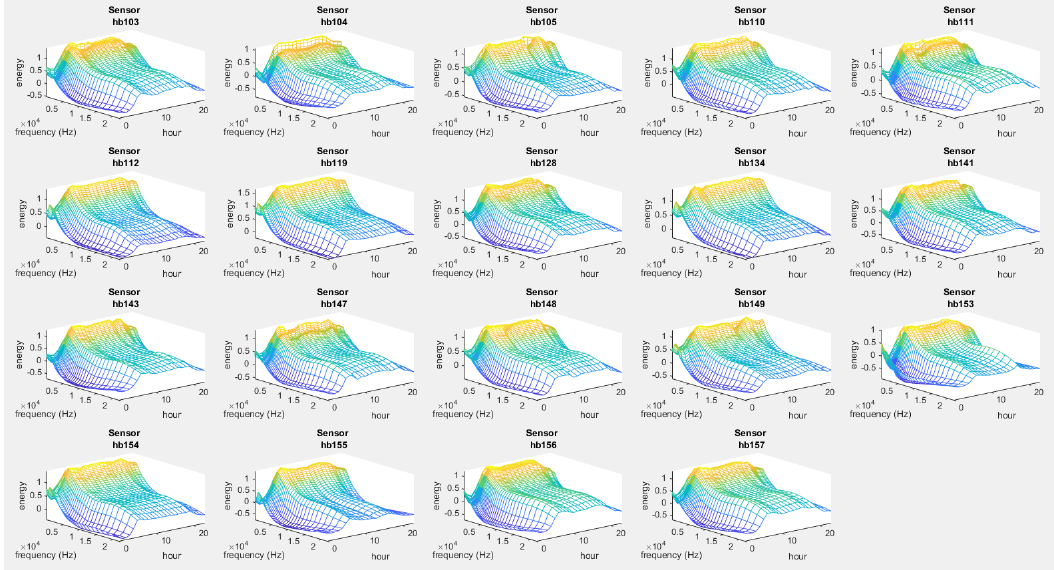
Figure 3. Spectrum-time profiles of the 19 sensors of the WASN on a weekday (2 November